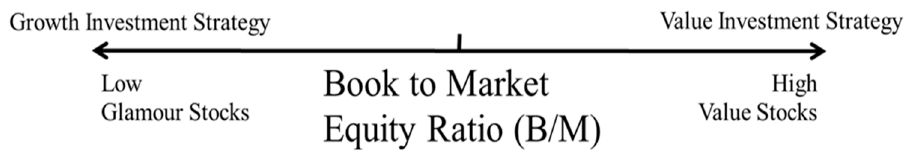
Figure 1. Value–growth investment strategy.